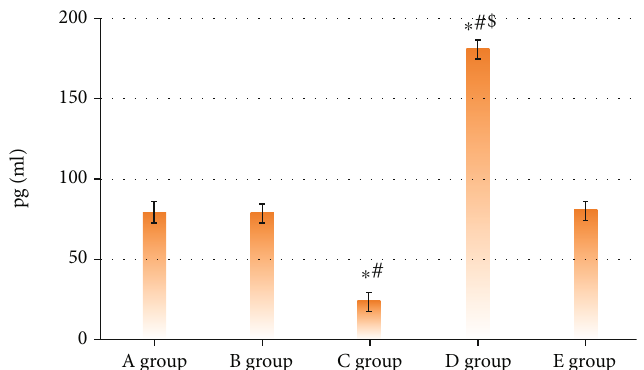
Figure 7: Levels of IL-18. ( ∗ , #, and $ indicated the comparison with group A, group B, and group C showed P < 0 : 05 , respectively.)